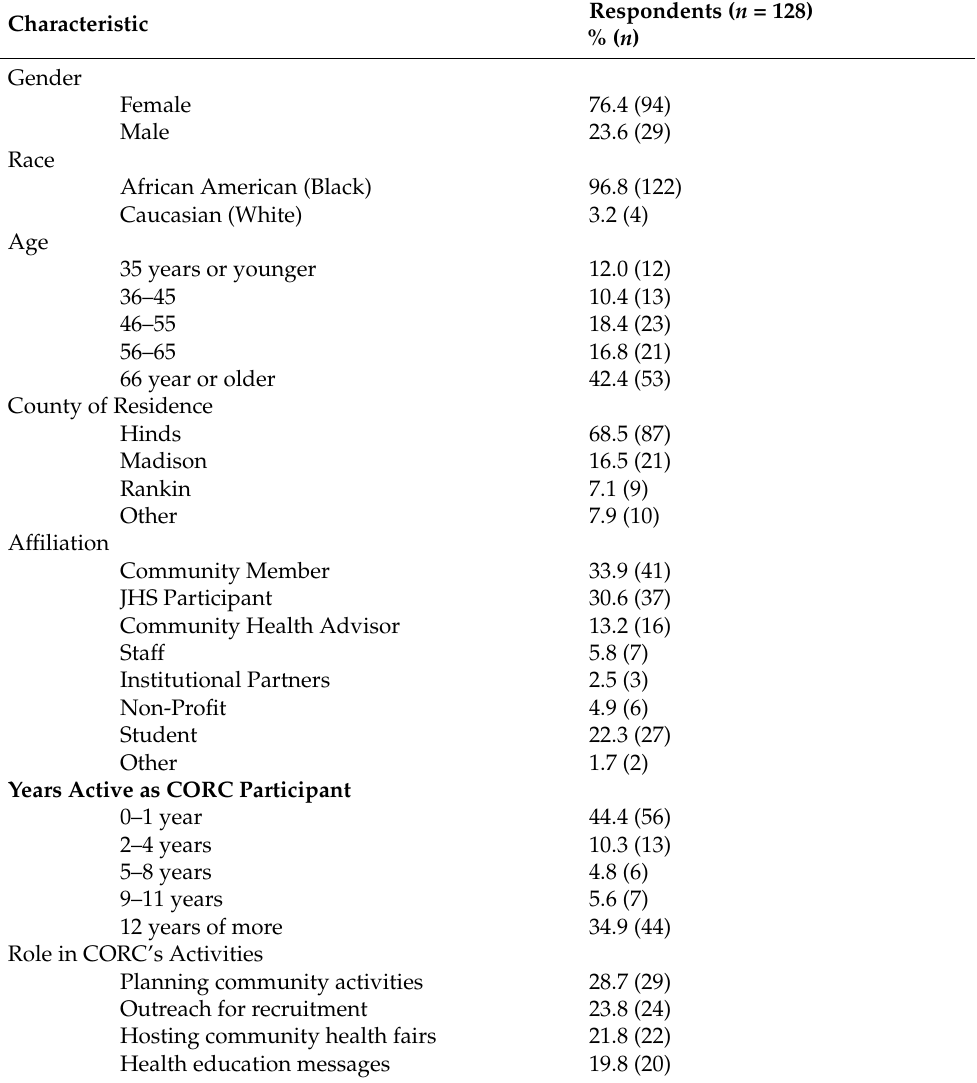
Table 1. Demographic Characteristics of